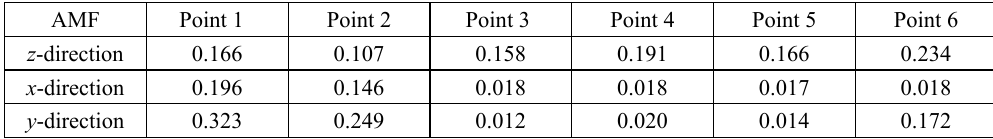
Fig. 8. Velocity components in the time domain at point 1 for r = 2 m; black line: the additional generator is used; gray line: the additional generator is removed; (a) velocity component in the z -direction, (b) velocity component in the x -direction, (c) velocity component in the y -direction Table 1. AMF for the points 1–2 located on the foundation level and 3–6 located on the highest floor as in Fig. 1, for r = 2